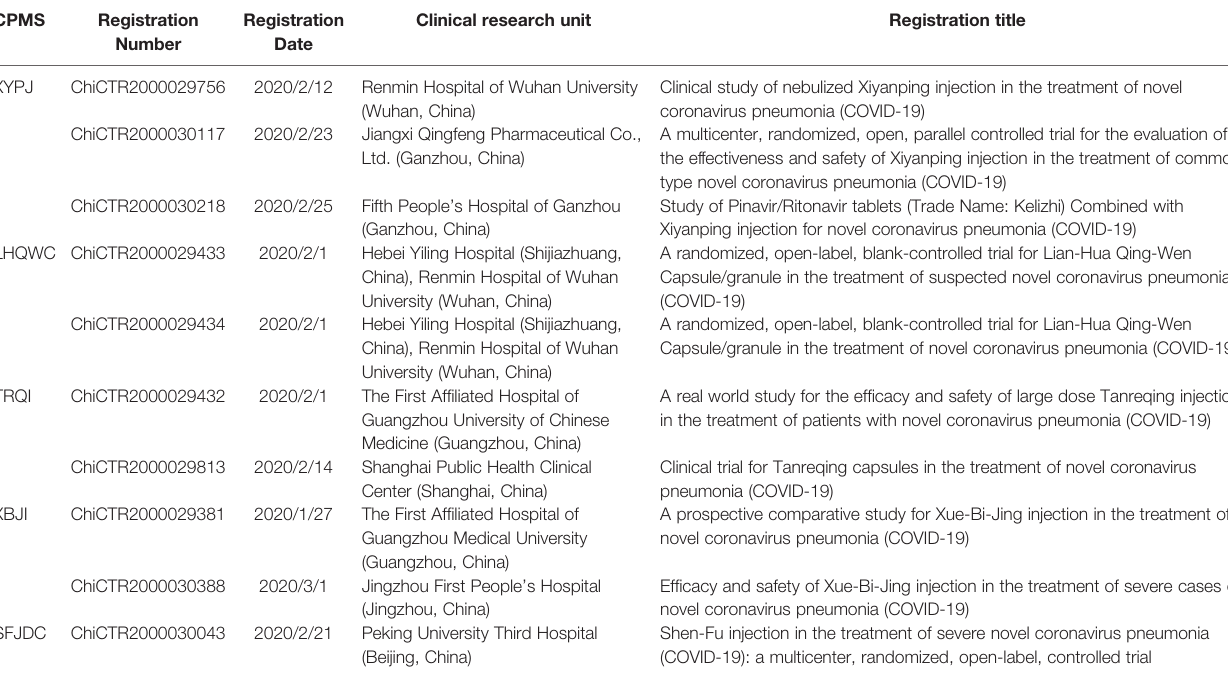
TABLE 4 | Registration information on clinical trial protocols for the top 10 CPMS in the treatment of COVID-19.